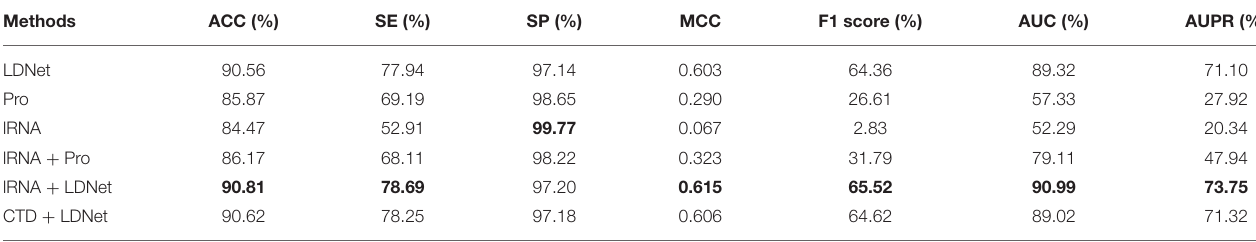
TABLE 2 | Performance of different feature subsets on the benchmark dataset. Methods